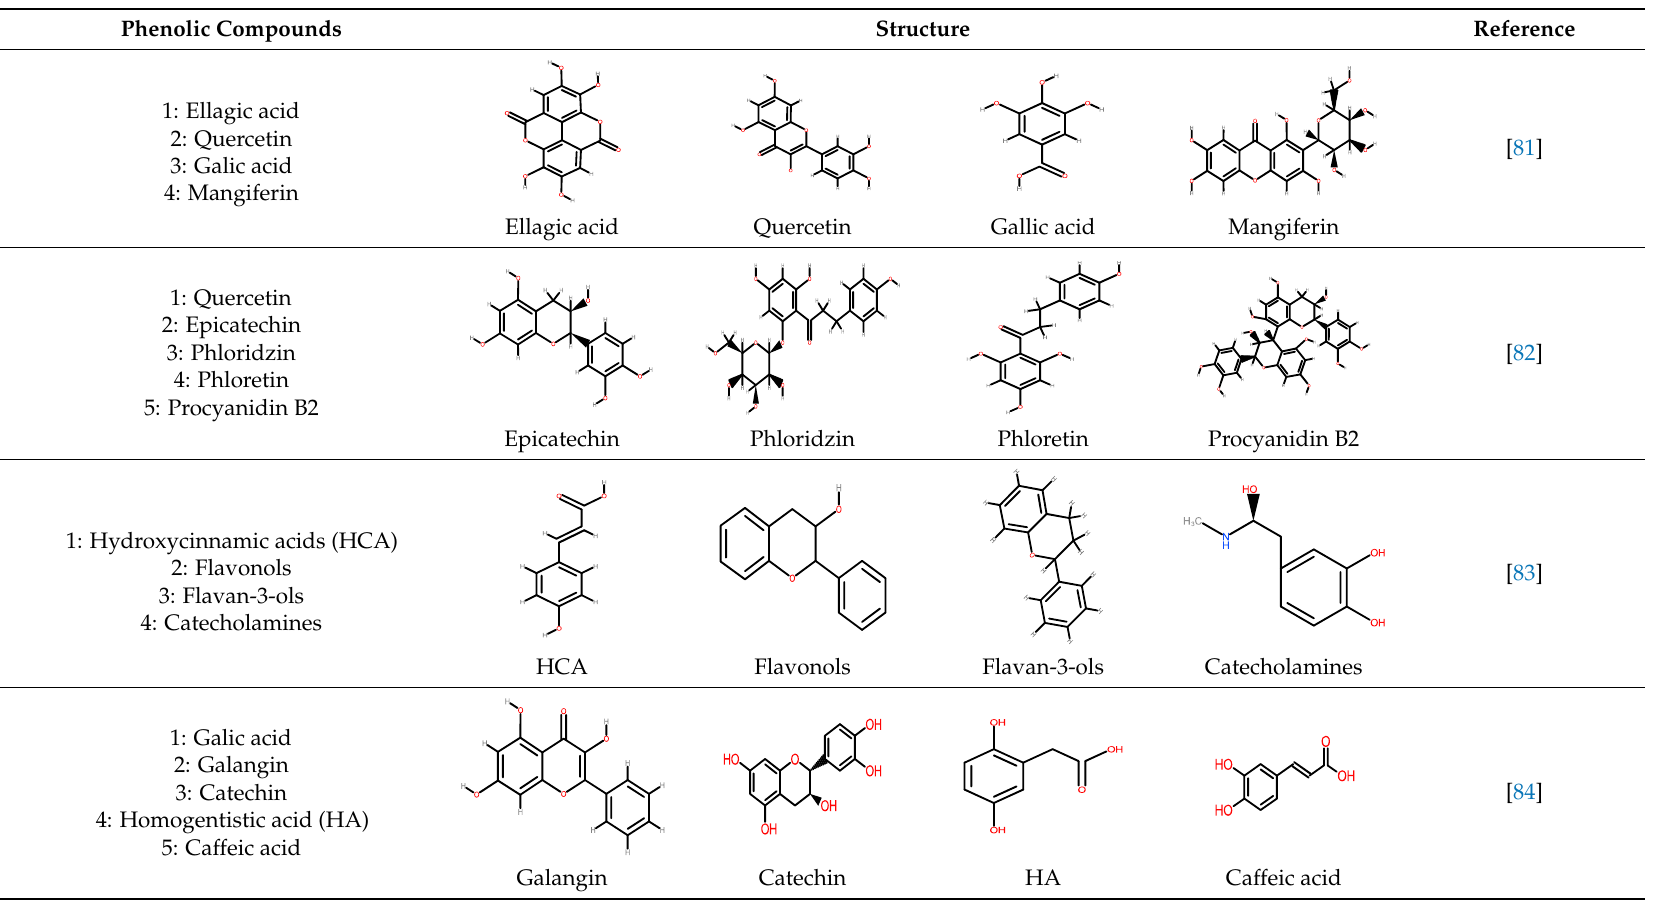
Table 3. Phenolic compounds and their structures identified in fruit waste.